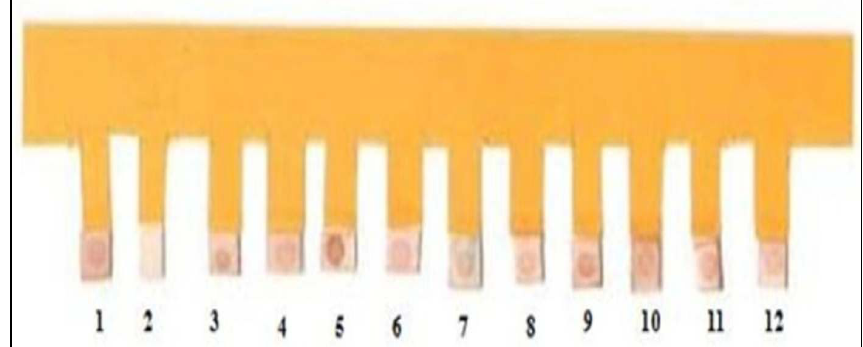
Figure-6: Dot-ELISA, 1: Positive control, 2: Negative control, 3-12: Representative positive